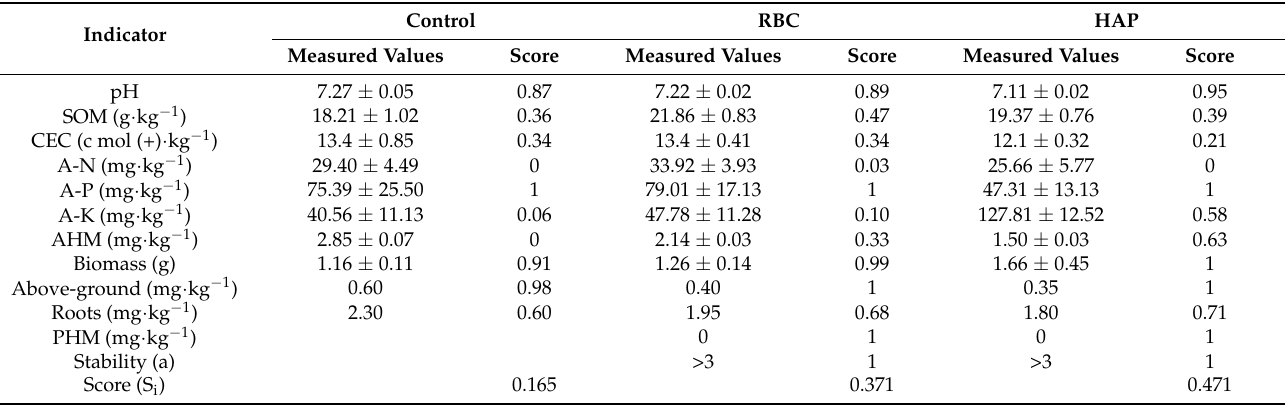
Table 10. Combined score of the two